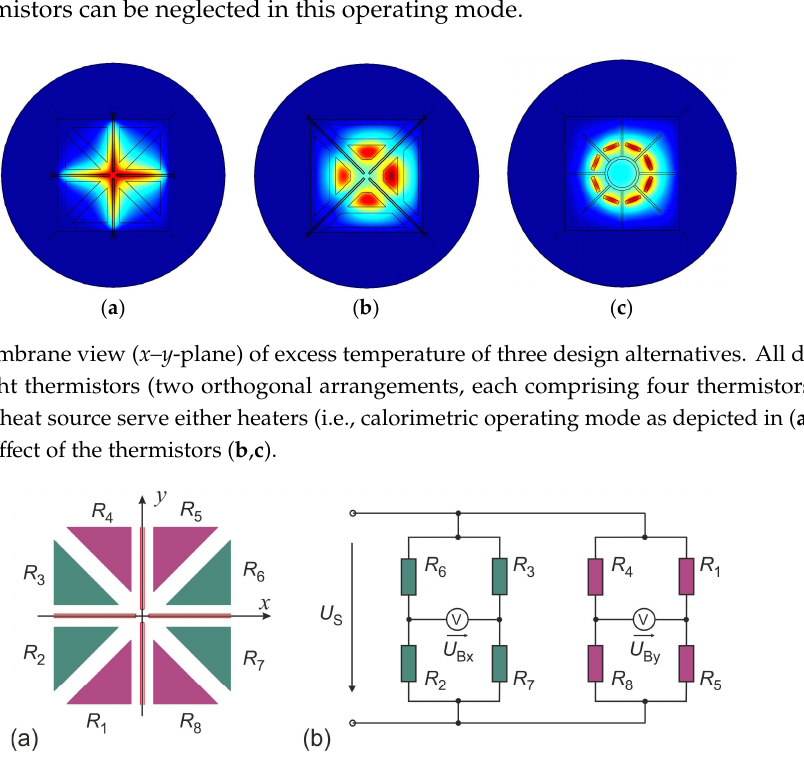
( b ) Figure 3. ( a ) Schematic cross section in y -direction of the flow sensor depicted in Figure 1a (m = 137.5 μm, n = 125 μm). ( b ) 3D FEM model of the flow sensor. It considers only a narrow cylindrical section around the sensor membrane and the flow channel above. The colors illustrate the temperature dis- tribution at the cross section through a membrane and parallel to the x–y -plane. For this particular simulation a rectangular flow channel of 0.5 mm height and 1 mm width was assumed, with an air- flow in y -direction and 1 m/s mean flow velocity. The heating power amounts to 3 mW and the am- bient temperature to 25 °C (which is also the fluid temperature). A rectangular flow channel of 1mm height and 12 mm width was assumed in accordance with the dimensions of the rectangular flow channel used for experiments. Thus, the modeled flow veloc- ity field exhibits no variation in flow direction and a parabolic dependence across the orthogonal plane to maintain non-slip boundary conditions at the top and bottom boundary of the flow channel. The trapezoidal cavity below the sensor membrane is filled with resting fluid. Its shape accounts for